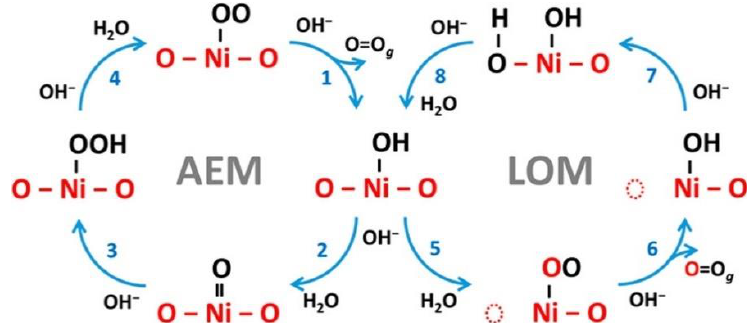
Figure 4. Demonstration of competition between the adsorbate evolution (AEM) and the lattice-oxygen mechanism (LOM). Reproduced with permission from [49]. American Chemical Society, 2018.